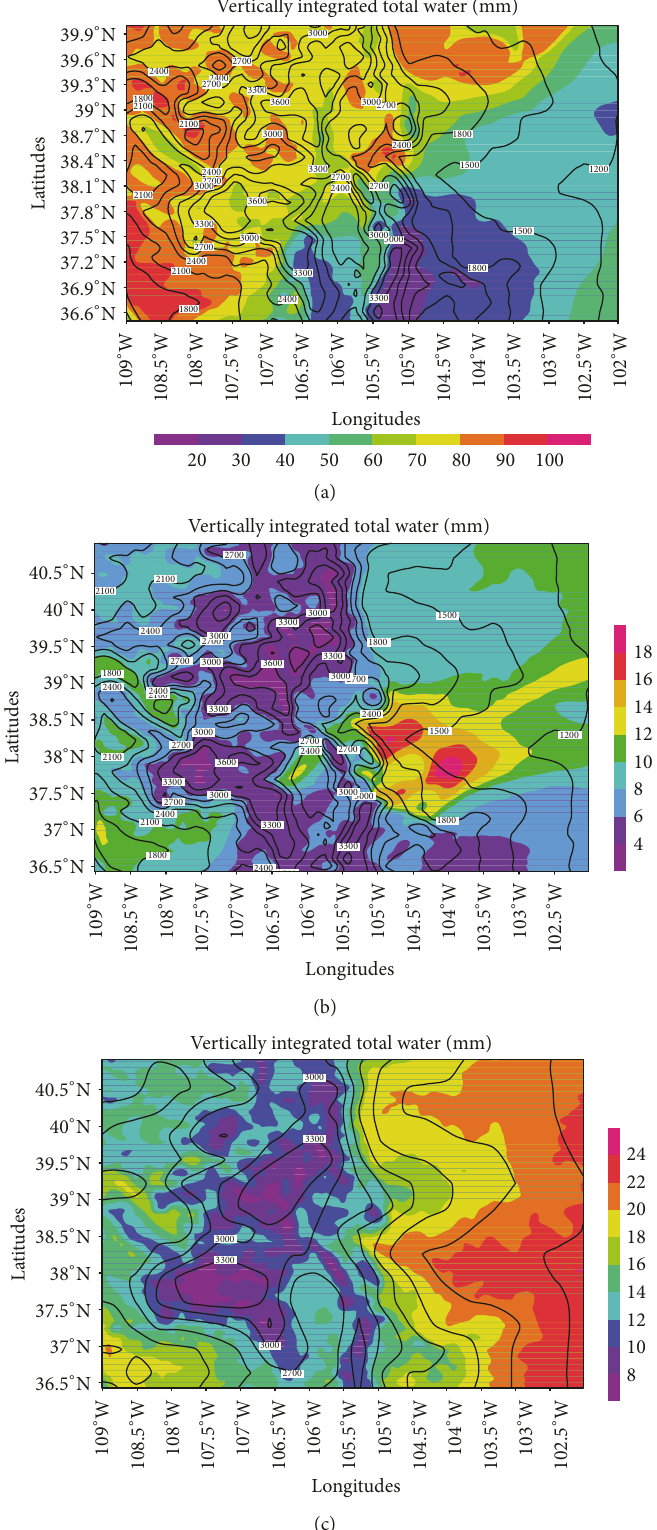
Figure 6: Total precipitable water for grid 3 for Case Study 1 (a); total precipitable water for grid 3 for Case Study 2 (b); total precipitable water for grid 3 for Case Study 3